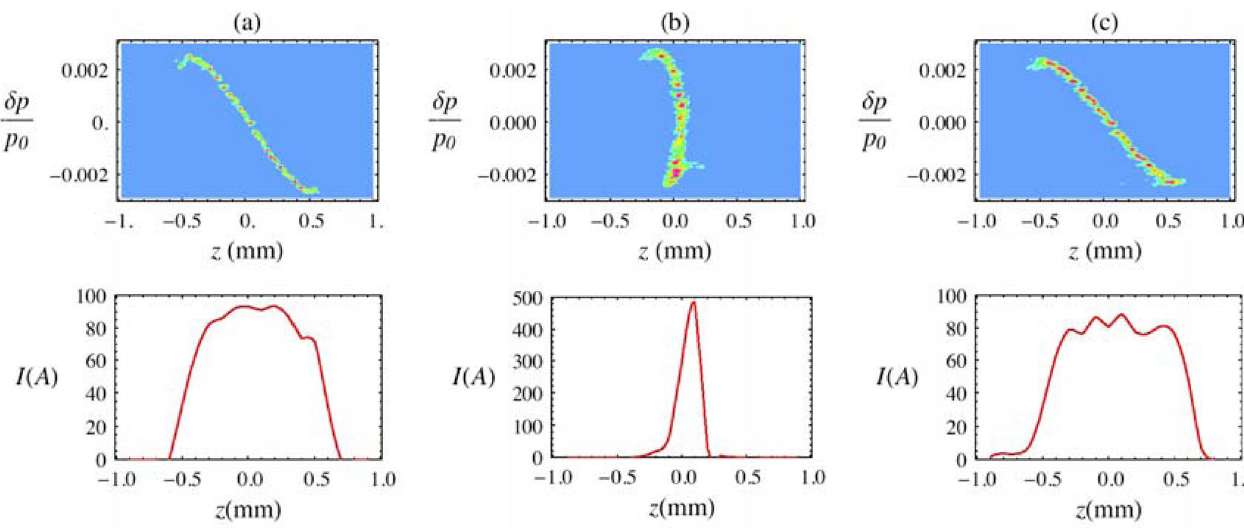
FIG. 8. (Color) ELEGANT simulations of the longitudinal trace space (upper plots) of the beam at ATF for VISA-I and corresponding current profiles (lower plots). The initial beam (a) shows a negative chirp, which undergoes a chicanelike compression (b). This compression is turned off (c) by the inclusion of sextupole